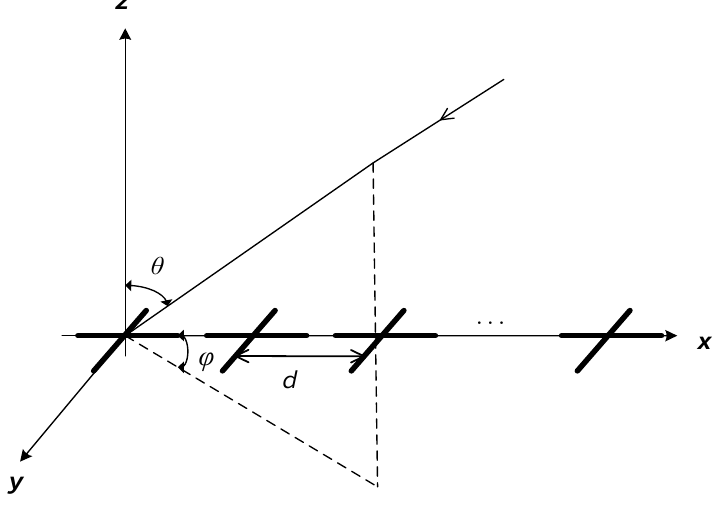
Figure 2. Uniform linear array